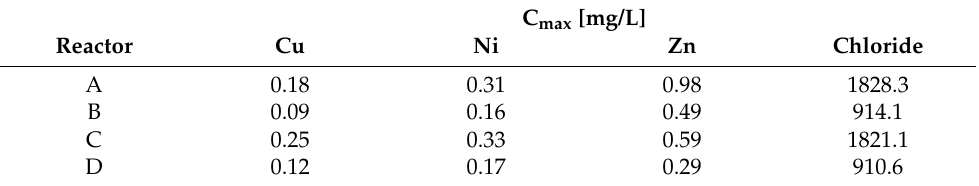
Table 5. Maximum concentration of HMs and chloride in feeding